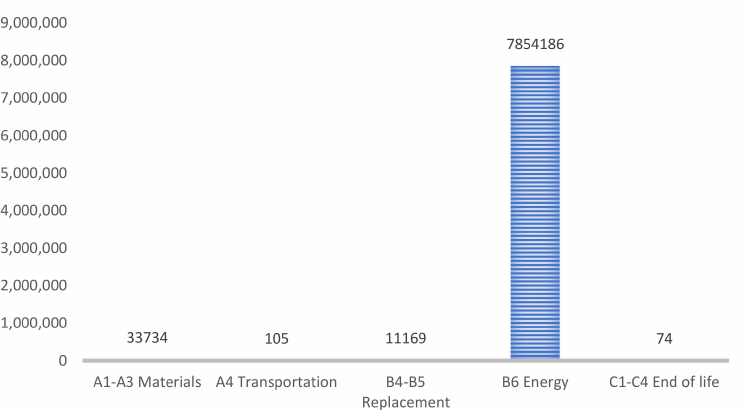
Figure 5. Scenario A: Global warming kg CO 2 -life-cycle stages.